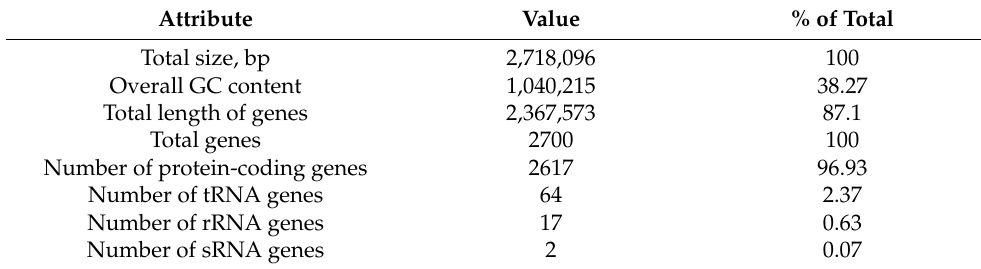
Table 1. Characteristics of the E. faecium FUA027